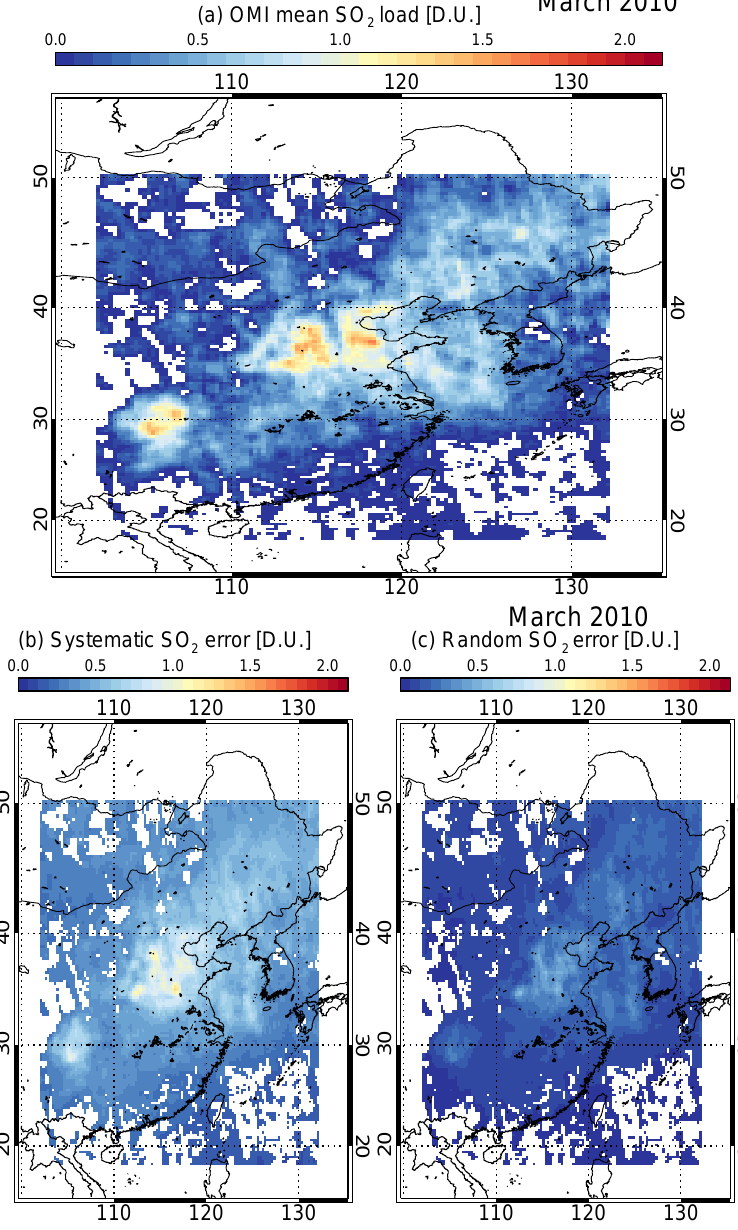
Figure 2. (a) The monthly mean OMI/BIRA SO 2 columns in D.U. for March 2010. (b) The associated systematic error (left) and random error (right) in D.U. calculated using Eq.